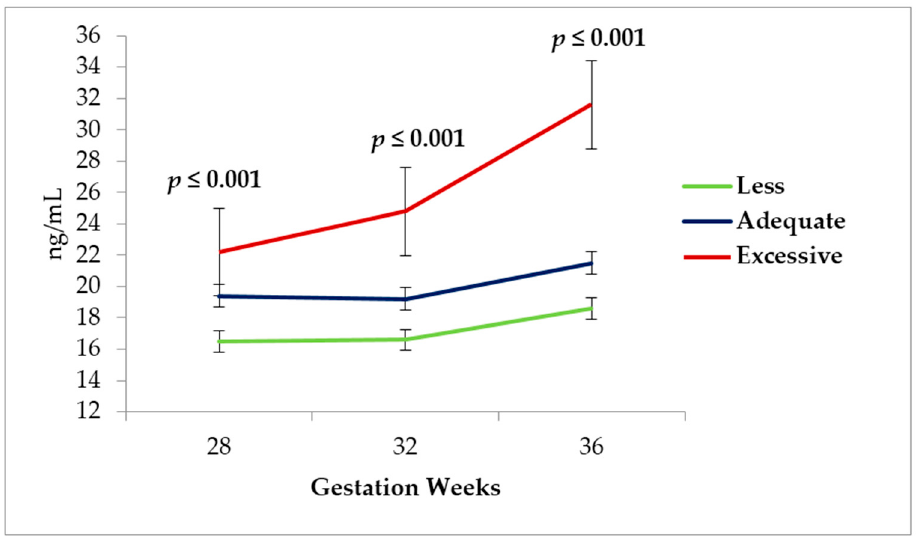
Figure 4. Evolution of serum concentration of maternal leptin (ng/mL) according to gestational Figure 4. weight gain.